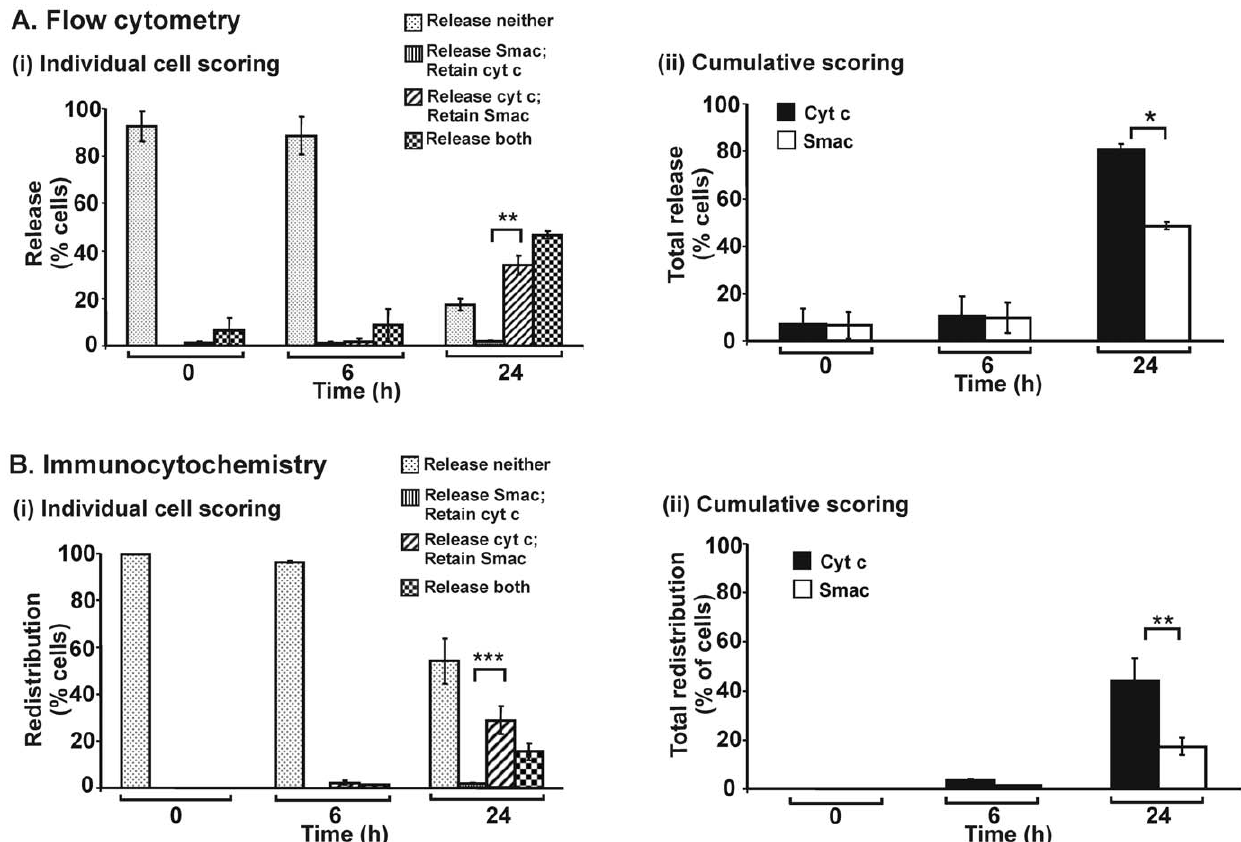
Figure 4. Differential redistribution of cyt c and Smac in 143B cells treated with STS. 143B cells were untreated or treated with STS (100 nM) for various times. (A) Flow cytometry data corresponding to the quantified quadrant occupancy in Figure 3C and F, averaged over three independent experiments: (i) indicates individual cell scoring for cells in each of four categories; (ii) indicates cumulative scoring for each of cyt c and Smac. Data for 3,000 events were collected for flow cytometry analysis in each individual experiment at each time point. (B) Direct immunocytochemical analyses of cells under four categories as indicated for each time point. 300 cells were scored for immunocytochemical analysis for each time point in each individual experiment. (i) and (ii) are as above for Panel A. Each standard error bar represents 6 SEM from three independent experiments. Asterisks indicate significant differences of cyt c and Smac redistribution (* P , 0.05; ** P , 0.005; *** P , 0.0005).